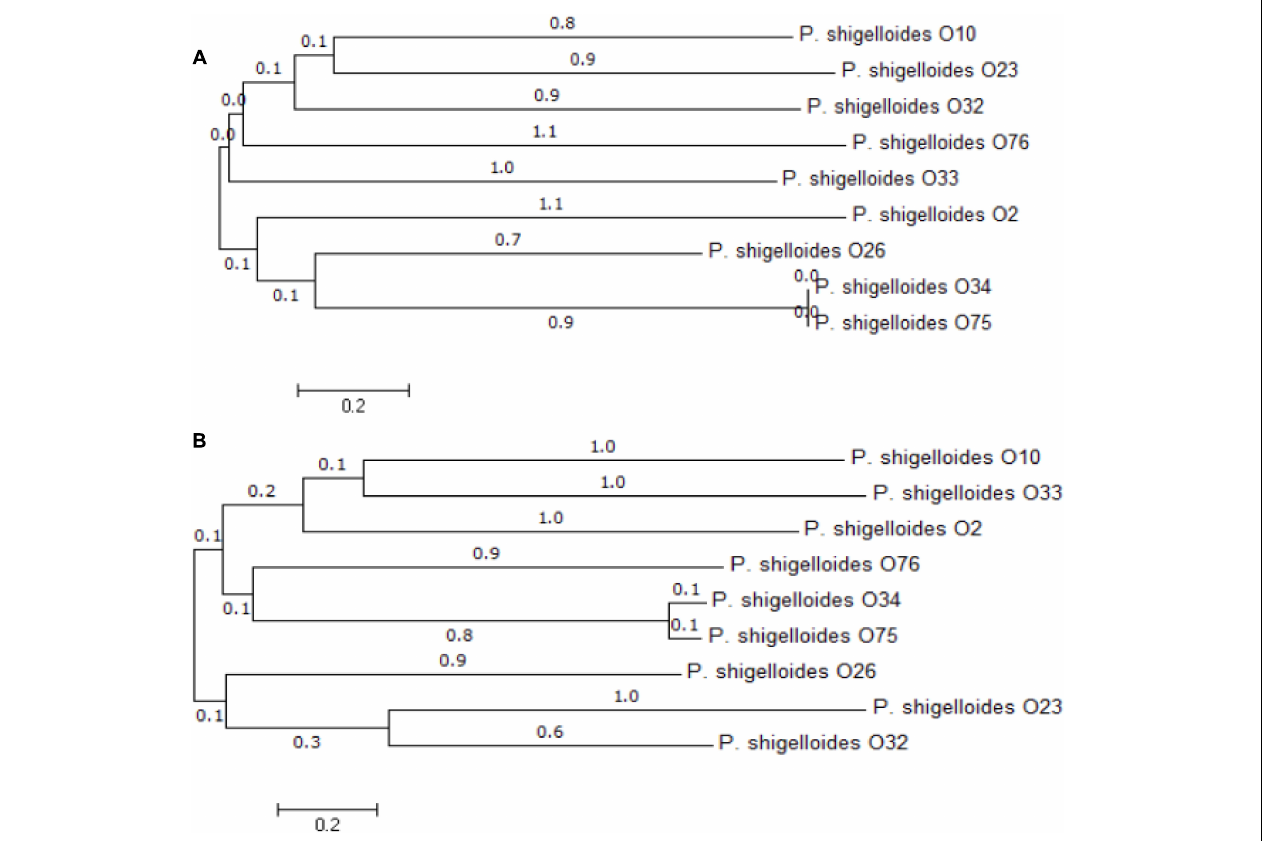
FIGURE 3 | Phylogenetic analysis. An unrooted phylogenetic tree constructed by the neighbor joining method based on the wzx (A) and wzy (B) genes is shown. Bootstrap values were based on 1000 replications and only values greater than 50% are